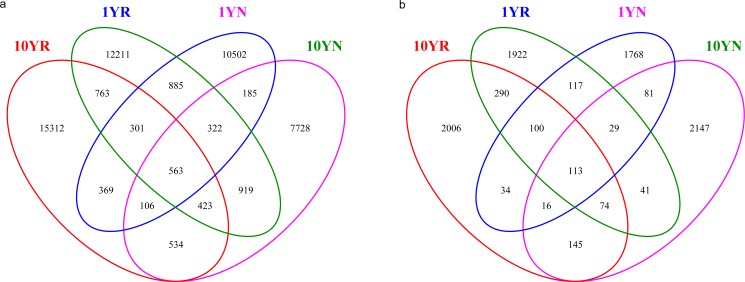
Venn diagram showing the number of unique bacterial (a) and fungal OTUs (b) detected in ramie soil samples.